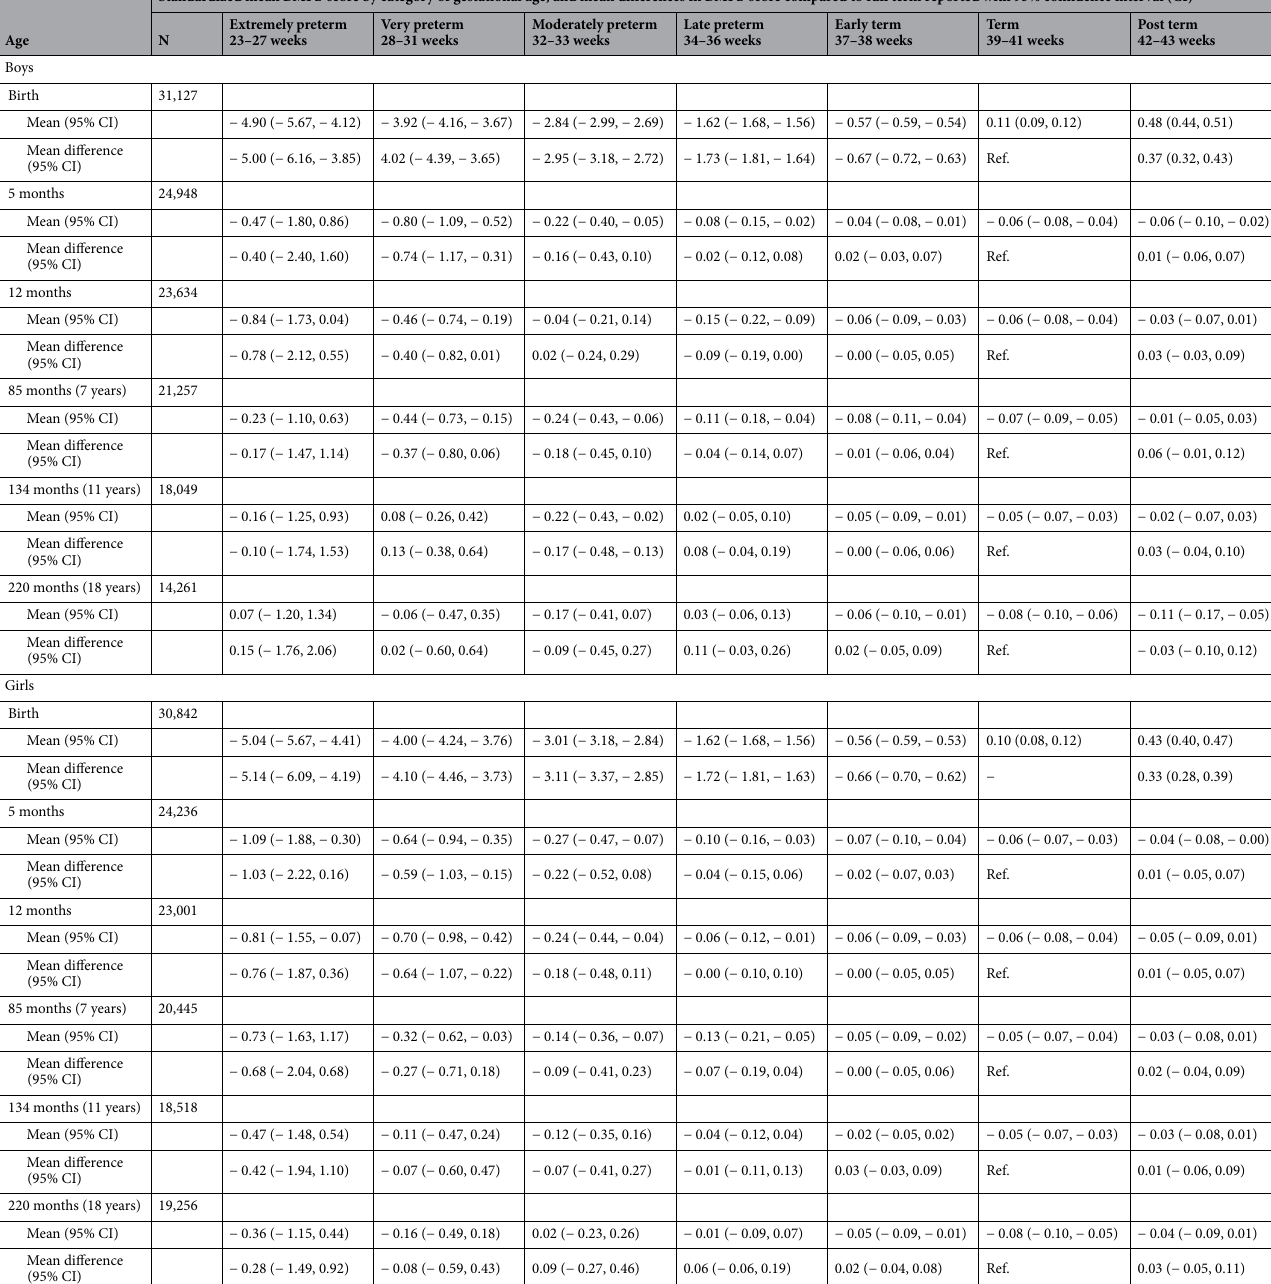
Standardized mean BMI z-score by category of gestational age, and mean differences in BMI z-score compared to full term reported with 95% confidence interval